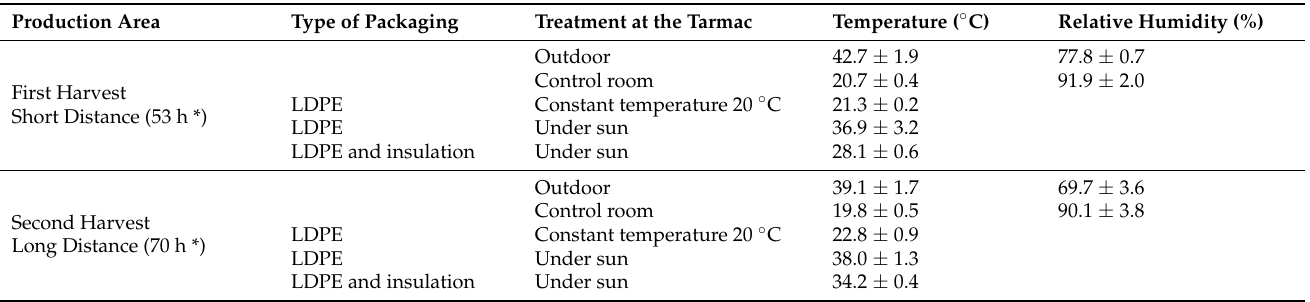
Table 2. Temperature ( ◦ C) and relative humidity (%) during the handling simulation on the tarmac. Production